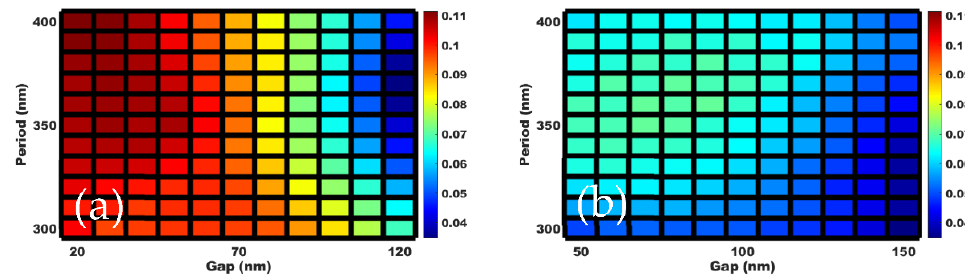
Figure 7. The calculated FoM Penalty on the loss of short-circuit current due to the color layer above a solar cell for varying period and gap of the TiO 2 resonator array, when ( a ) the resonator array is placed on a silica substrate and ( b ) the resonator array is embedded inside a silica medium. The second FOM— FoM Total-UV (Equation (2))—estimates the UV blocking at the color layer in the spectral region of 320–400 nm. Here, the UV blocking happens in two ways.